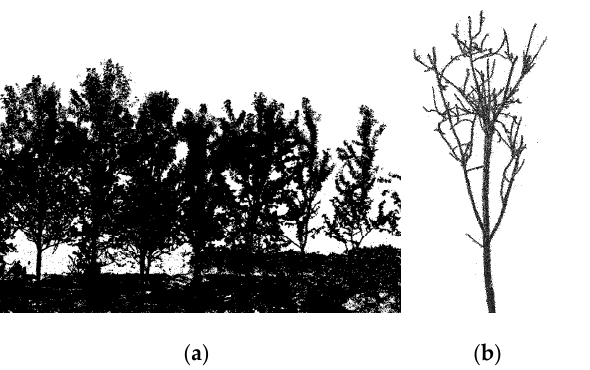
Figure 2. Flowchart of virtual forest modeling.